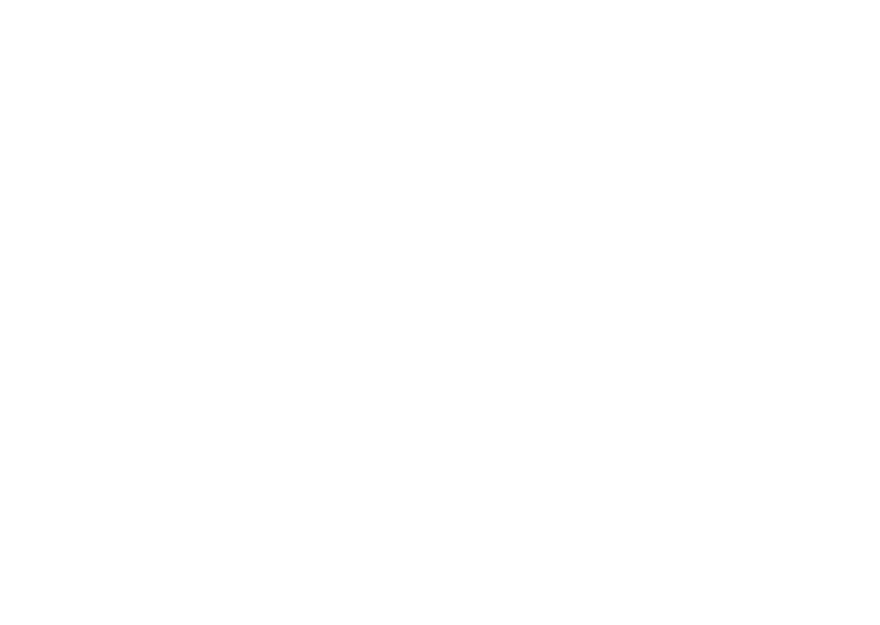
Fig. 2: Photograph of skiagram of atlas vertebra showing spicules (S) projecting inferiorly from the anterior arch of the atlas